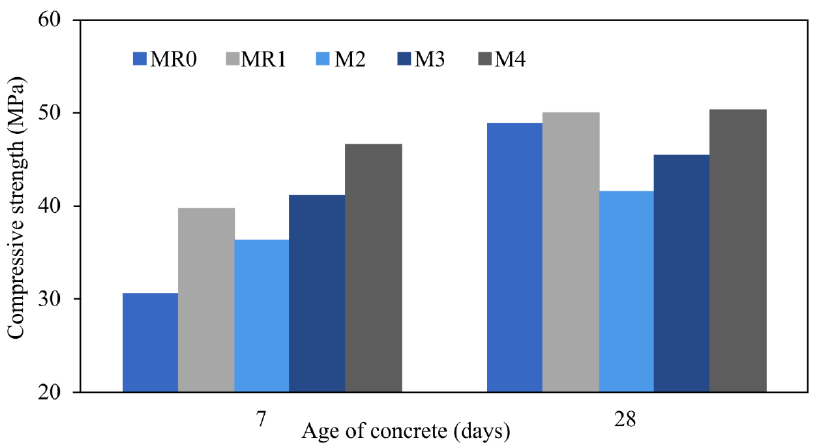
Figure 8. Compressive strength of geopolymer with different mixtures [134].